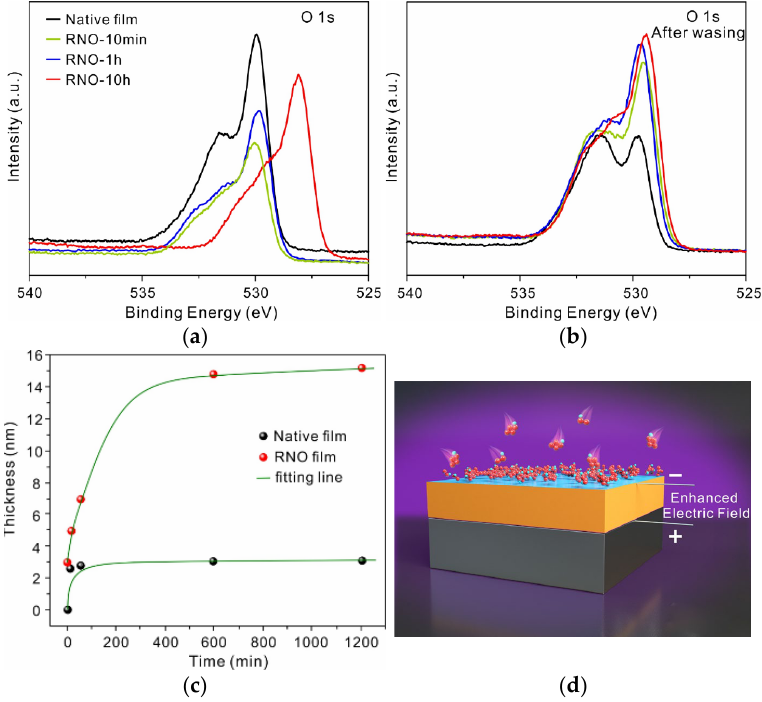
Figure 5. ( a ) XPS spectra of the O 1s core level in 316L SS films with varying treatment time. ( b ) O 1s spectra of the same samples after washing with ultrapure water. ( c ) Film thickness of 316L SS as a function of treatment time. ( d ) Schematic illustration of the growth mechanism of the RNO film.